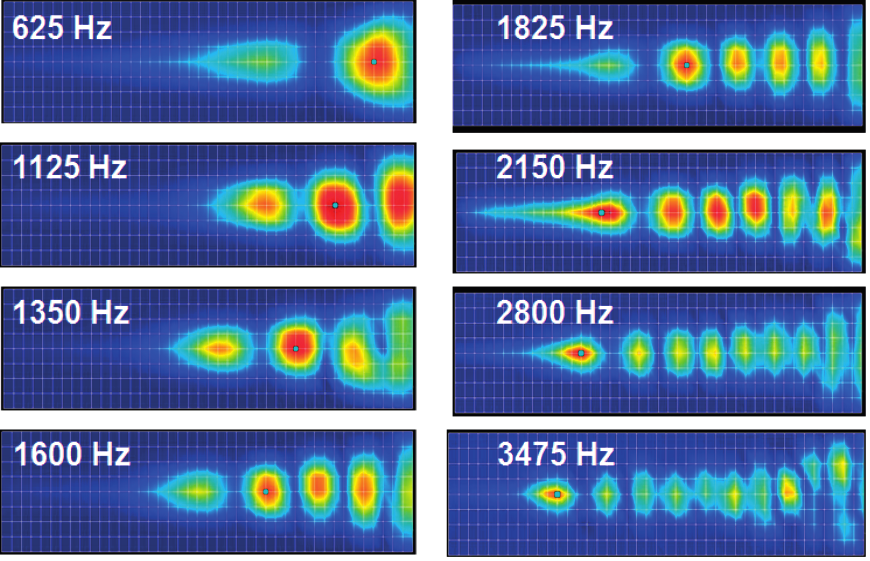
Figure 9. 2D displacement measurement of membrane movement by LDV: The apex is near the right end of image and the base is near the left end of image.